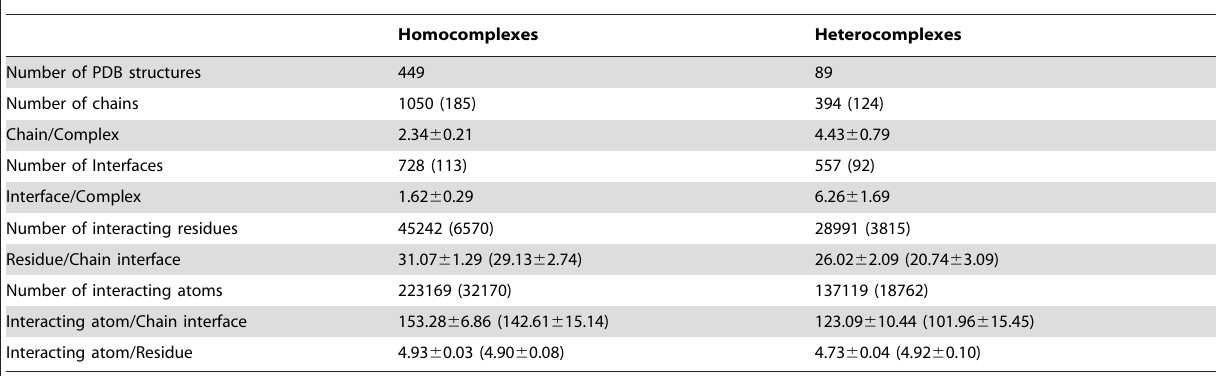
Table 1. Summary of analysed datasets.